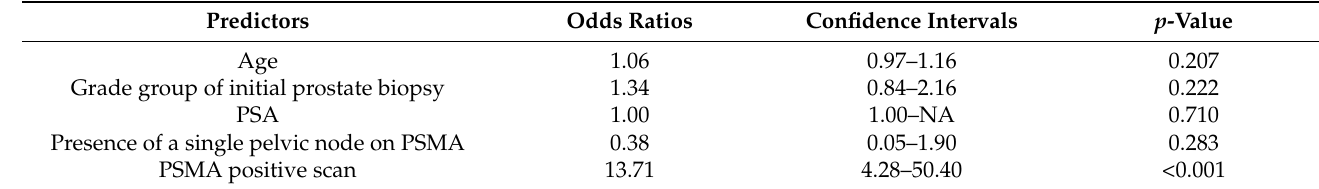
Table 7. Multivariate analysis of factors predicting a change in